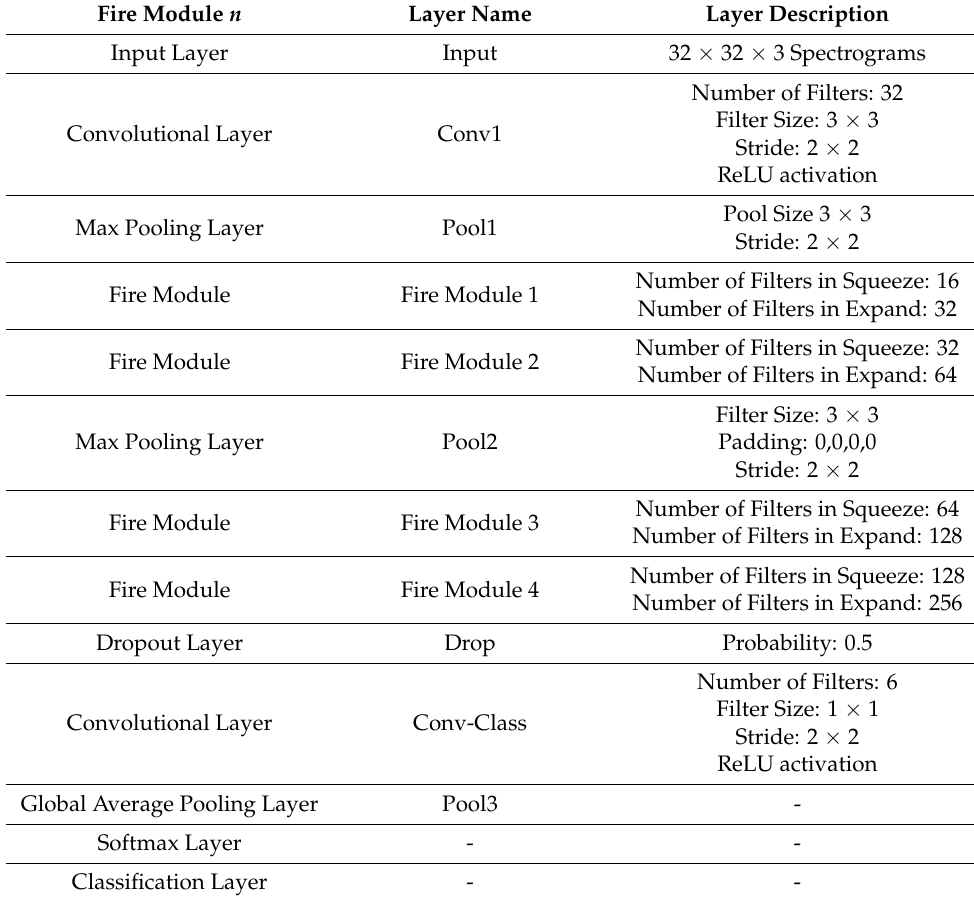
Table 3. Layer details and descriptions of the modified